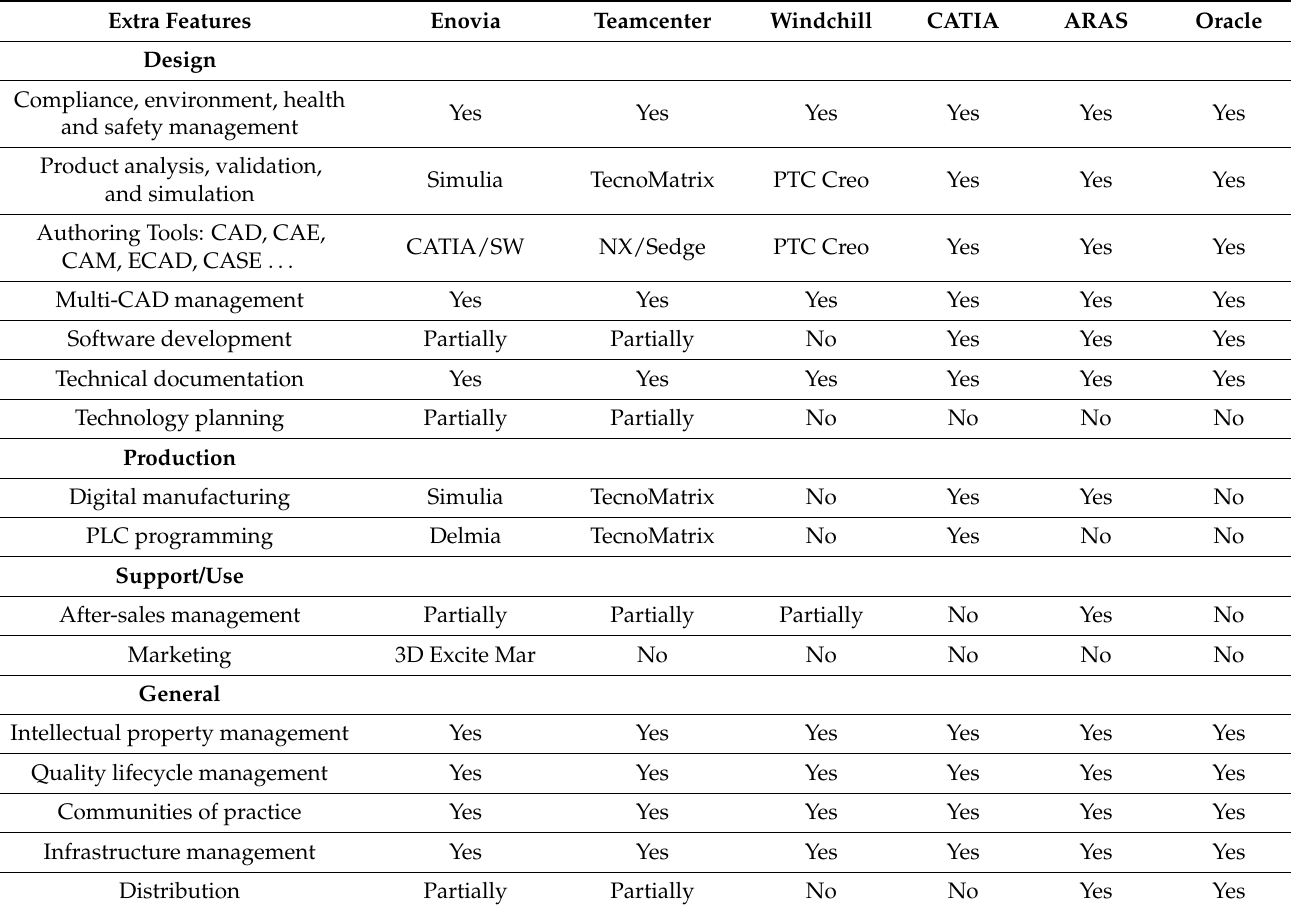
Table 2. Extra features included in top PLMs [11] “Adopted with permission from Enriquez et al. (2018). Copyright © 2018